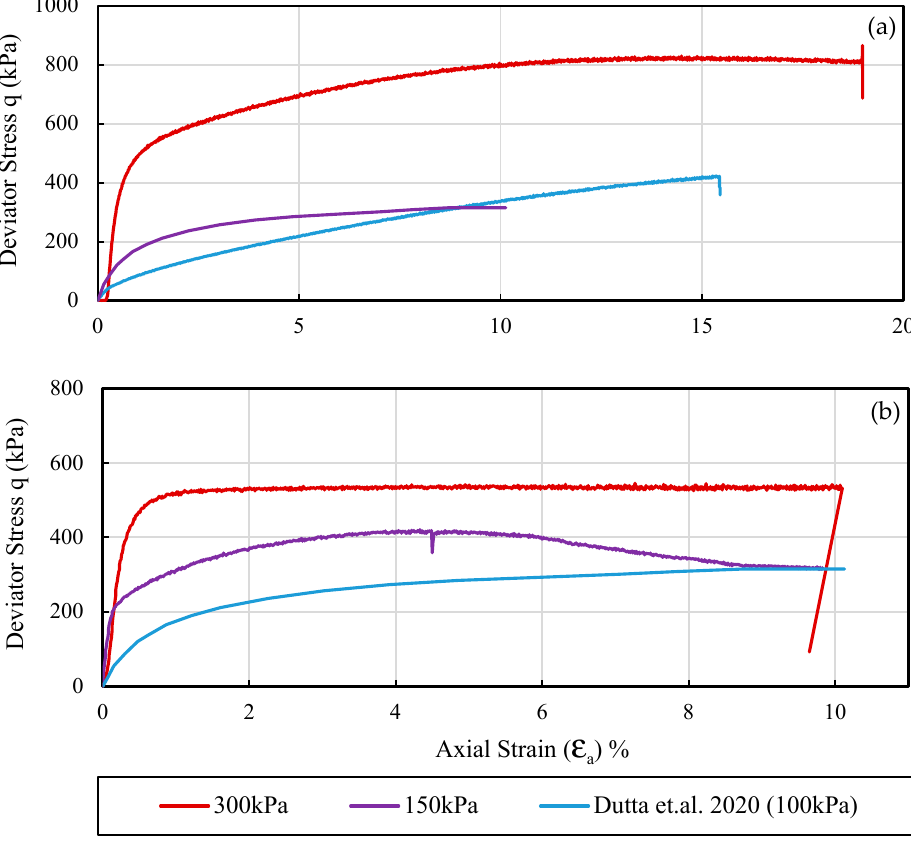
Figure 7. Stress–strain curve from siliceous sand (Dutta et al. [8]) at σ 3 of 100 kPa and this study ( a ) sample A, and ( b ) sample B.